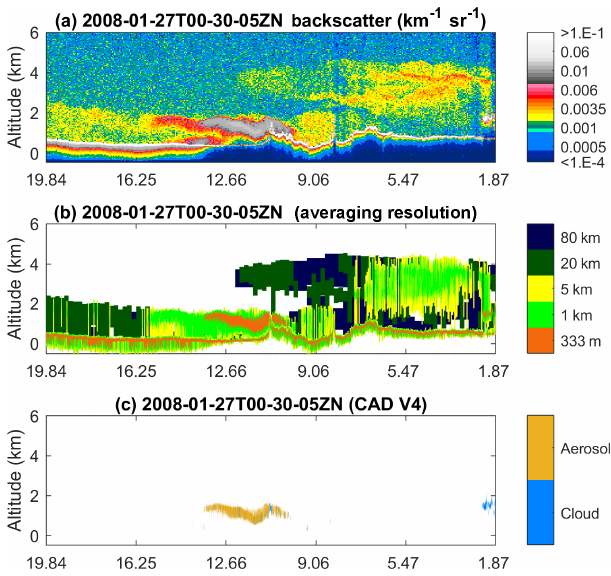
Figure 23. (a) V4 532nm total attenuated backscatter coefficients and (b) horizontal averaging required for layer detection for a scene containing a strongly scattering aerosol layer observed on 27 Jan- uary 2008 between latitudes of ∼ 13 and ∼ 10 ◦ N. Cloud–aerosol classification of the V4 atmospheric layers detected at 333m is shown in panel (c) . Note that the Earth’s surface is also detected at the 333m resolution, as seen in panel (b) , but these features are not plotted in panel (c)